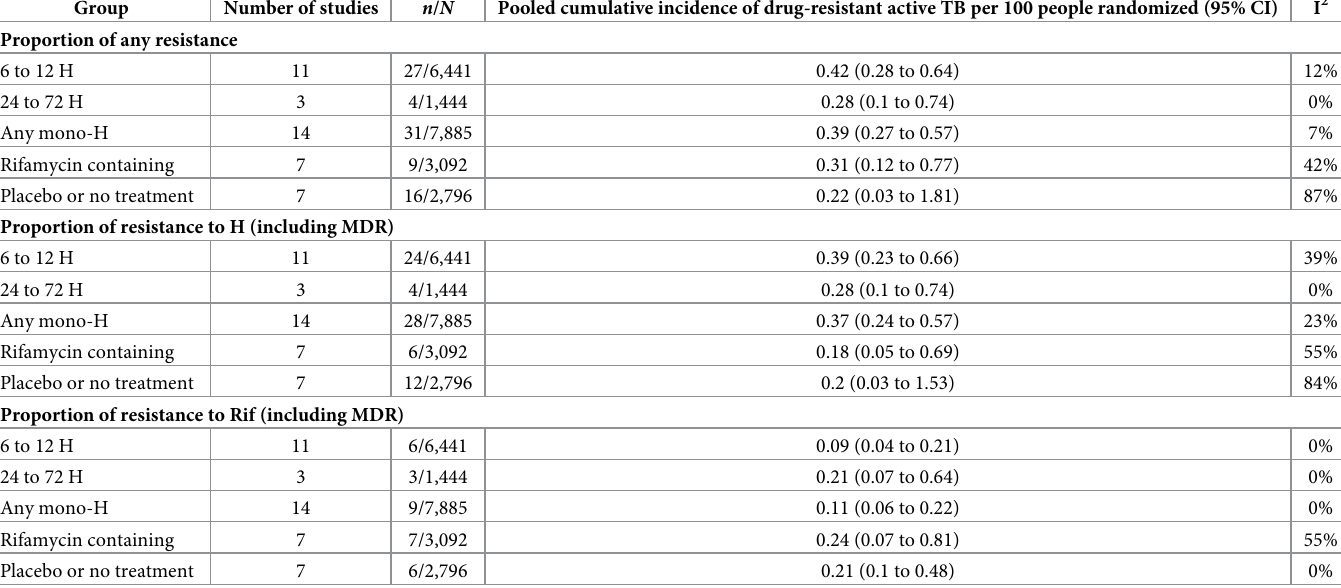
IGRA positive PLHIV with 24 or 36H and with rifamycin-containing regimens when com- pared to placebo. However, for TST/IGRA negative or TST anergic PLHIV, there was no sta- tistically significant difference in incidence with these TPT regimens compared to placebo. Table 6. Aggregate meta-analysis of the cumulative incidence of drug-resistant TB by aggregated TPT regimens.